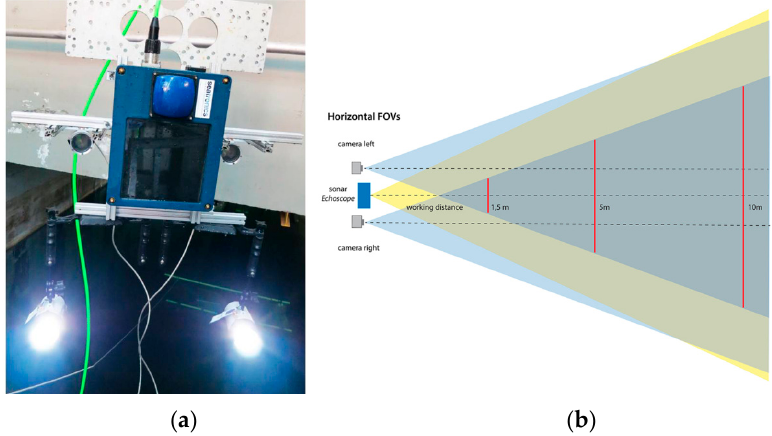
Figure 3. Layout of the opto-acoustic 3D camera ( a ). A scheme showing the overlap of the FOVs of Echoscope sonar and optical cameras ( b